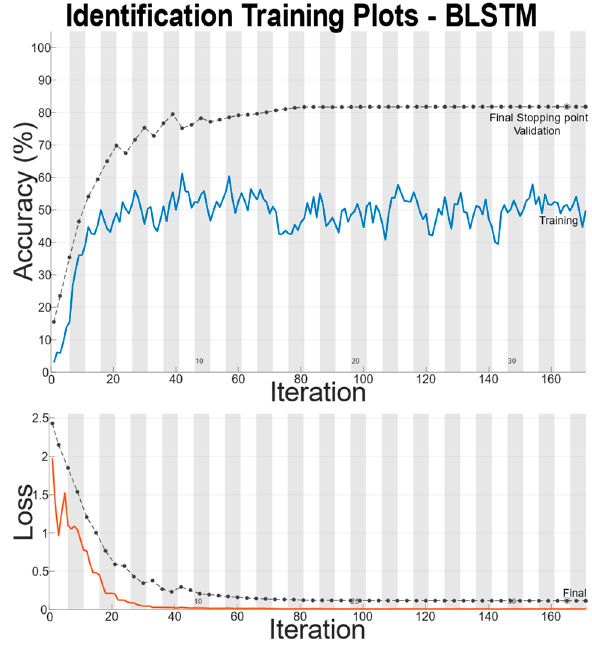
Figure 7. Training Plot for Best Performing Identity Network.